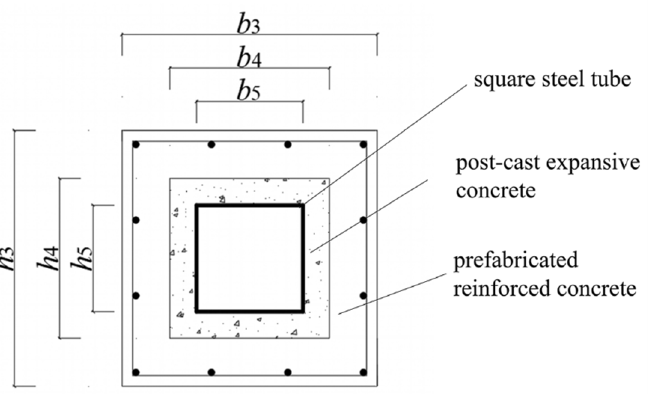
Figure 6. Sectional diagram of vertical part of prefabricated cantilever component.